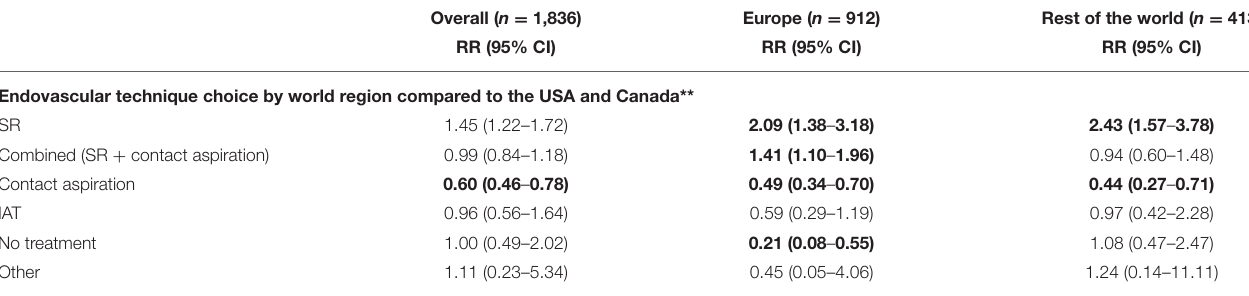
TABLE 2 | Likelihood of preferred first-line endovascular treatment approach across world regions (reference: USA and Canada).